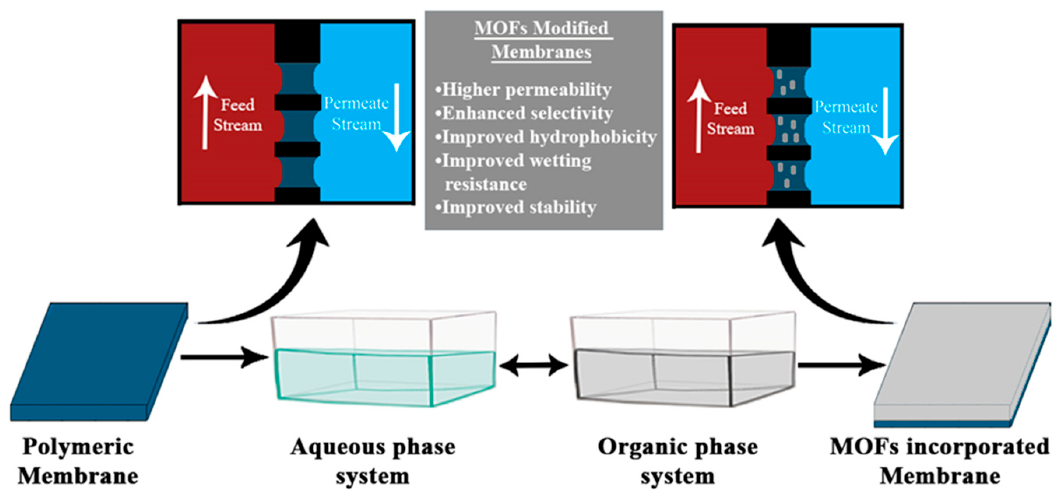
Figure 11. Incorporation of metal organic frameworks (MOFs) by interfacial polymerization utilized in the MD process.